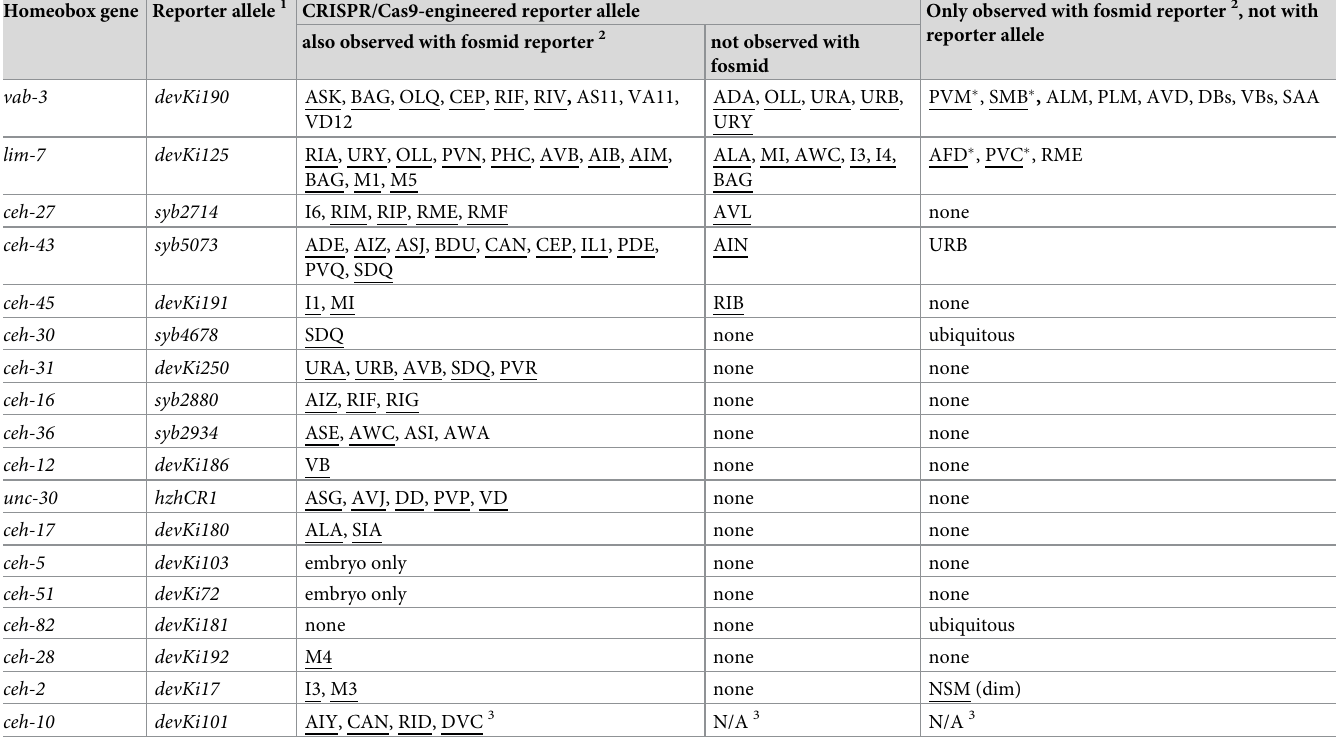
Table 1. Comparing expression patterns of CRISPR/Cas9-engineered reporter alleles with fosmid-based reporter transgenes. Homeobox gene Reporter allele 1 CRISPR/Cas9-engineered reporter allele Only observed with fosmid reporter 2 , not with